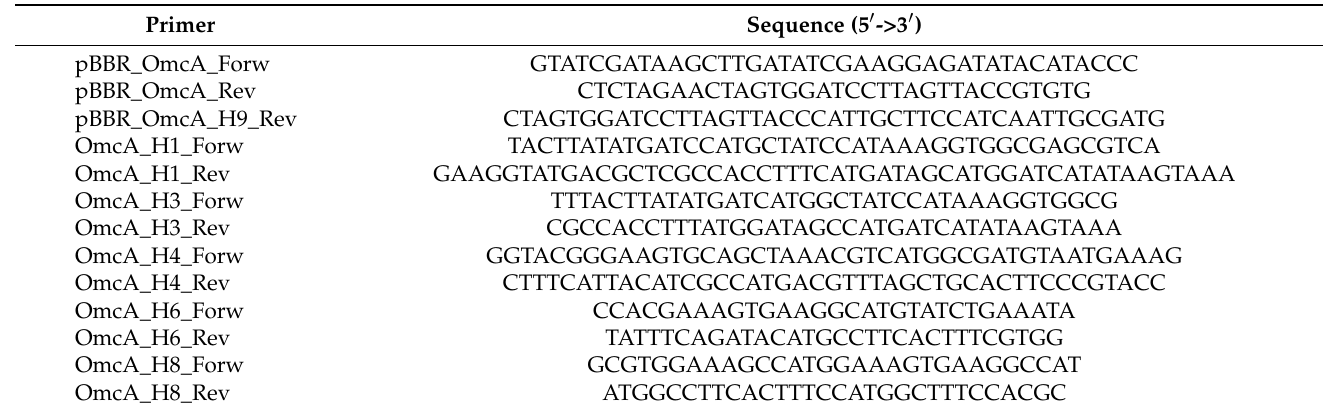
Table 1. List of primers used for this work.